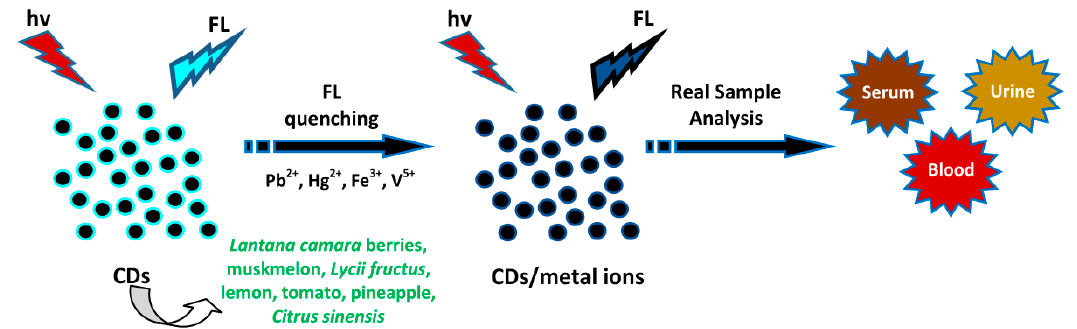
Figure 12. Schematic illustration of plant part-derived CDs for the sensing of various metal ions in biological samples. The addition of different metal cations produced a quenching effect on the FL intensity of CDs. Real sample analysis was performed to detect metal cations in biological samples.